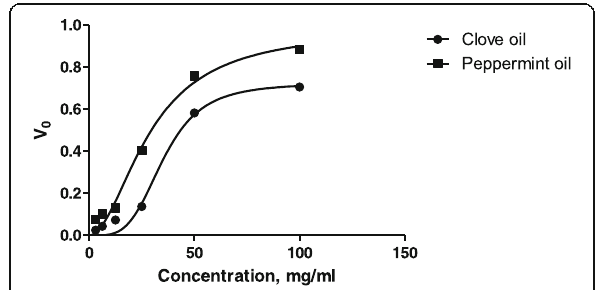
Fig. 5 Sigmoidal response curves of clove oil and peppermint oil